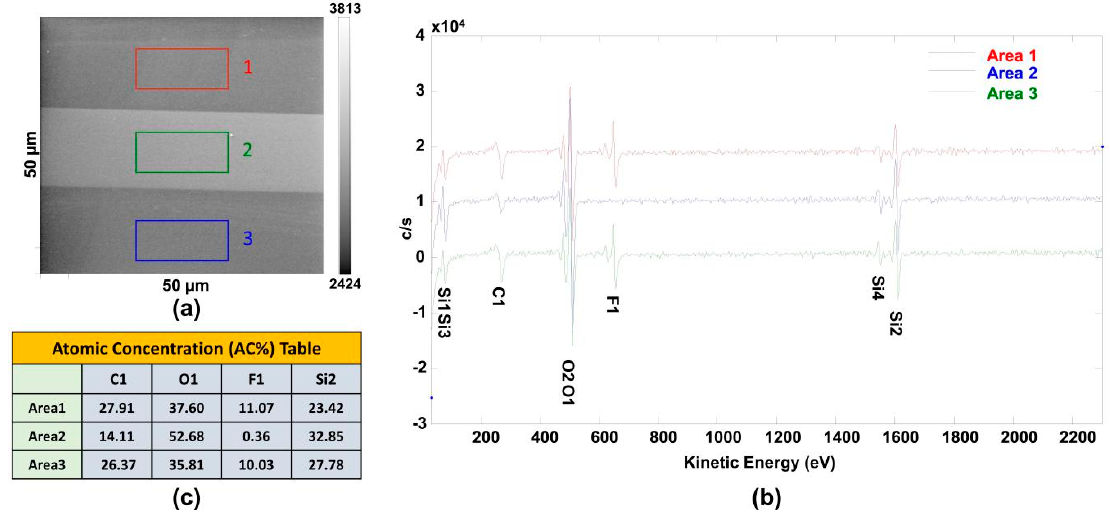
Figure 2. ( a ) Secondary electron SEM image of an area of 50 µm by 50 µm. Area1 (red rectangle) and Area3 (blue rectangle) were selected in dark areas containing FDTS SAM film patterns, while Area2 (green rectangle) was selected in light areas containing silicon dioxide film patterns. ( b ) Auger electron spectra collected from Areas1 (red line), Area2 (blue line) and Area3 (green line) shown in ( a ). ( c ) Atomic concentration (AC%) of four elements’ KLL Auger electrons on Area1, Area2, and Area3.